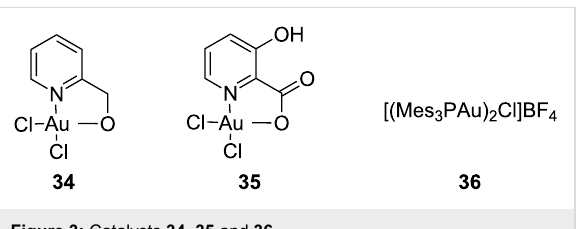
Figure 3: Catalysts 34 , 35 and 36 .